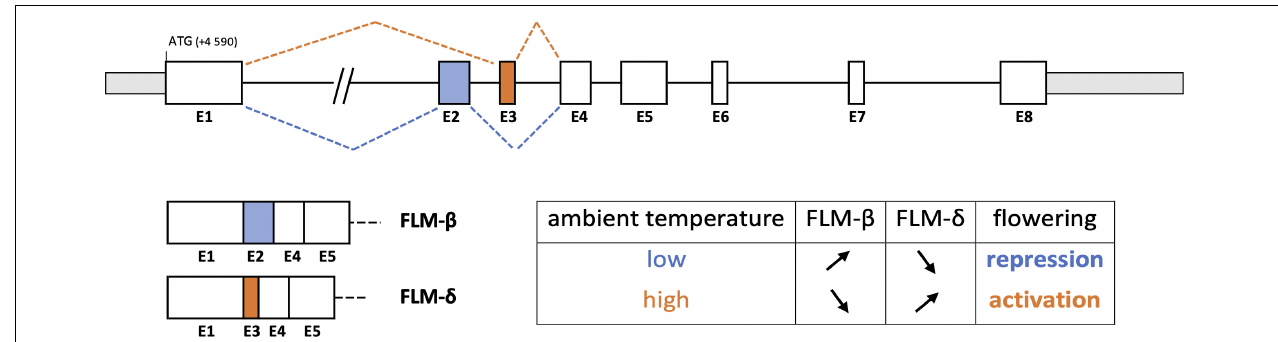
FIGURE 1 | Temperature-dependent alternative splicing of FLOWERING LOCUS M (FLM) in Arabidopsis thaliana (Capovilla et al., 2017). Alternative usage of exons 2 and 3, two mutually exclusive exons, acts as a thermosensitive regulator in the flowering time pathway. The FLM- β variant isoform is down-regulated by increasing ambient temperature while the FLM- δ variant is up-regulated, inducing